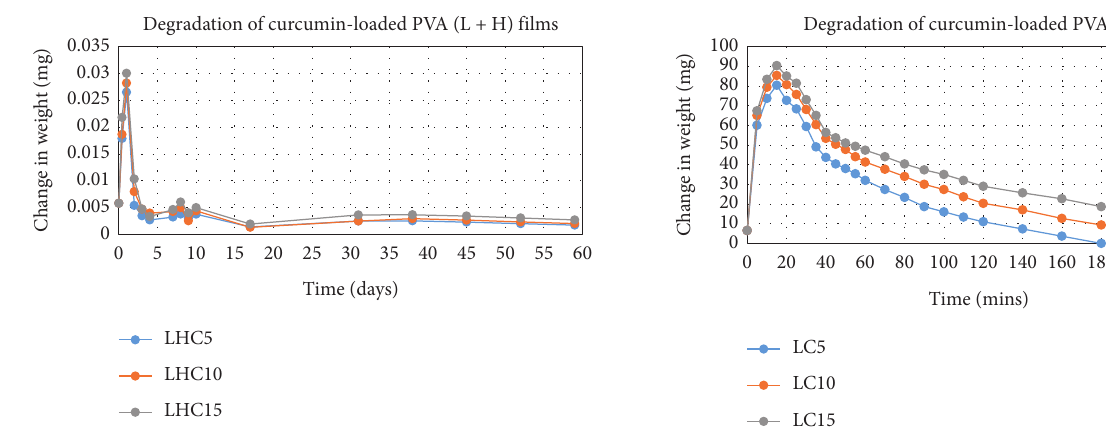
Figure 1: Degradation of curcumin-loaded PVA (L+H) films.